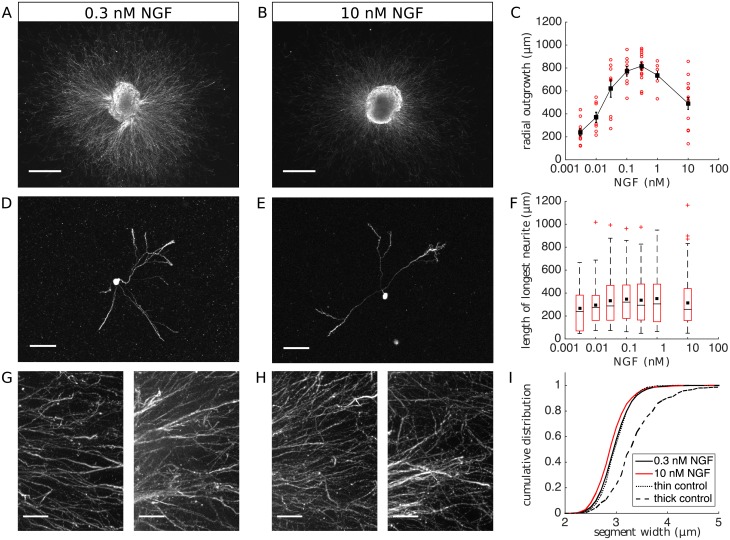
NGF dependence of neurite growth and fasciculation.DRG explants and dissociated cells grown in collagen for 48 h with various NGF concentrations were stained with TuJ1 for neurite visualisation. (A,B) Representative examples of explants at 0.3 nM and 10 nM demonstrate the reduction in outgrowth at high NGF concentrations (scale bars 500 μm). (C) Quantification of average explant outgrowth shows a biphasic NGF dependance. Red markers correspond to individual explants, error bars are SEM. (D,E) Representative examples of dissociated cells at 0.3 nM and 10 nM demonstrate the absence of growth inhibition (scale bars 100 μm). (F) Quantification of dissociated-cell neurite lengths. Black lines are medians, black squares are means, and red crosses are outliers from 20 − 156 cells per condition. (G,H) Representative images of neurites extending from explants in 0.3 nM and 10 nM NGF concentrations at higher magnification (scale bars 50 μm). (I) A comparison of neurite bundle widths shows no increase in fasciculation at 10 nM NGF. Our method of image analysis easily detects differences in control sample patches of thin and thick bundles.